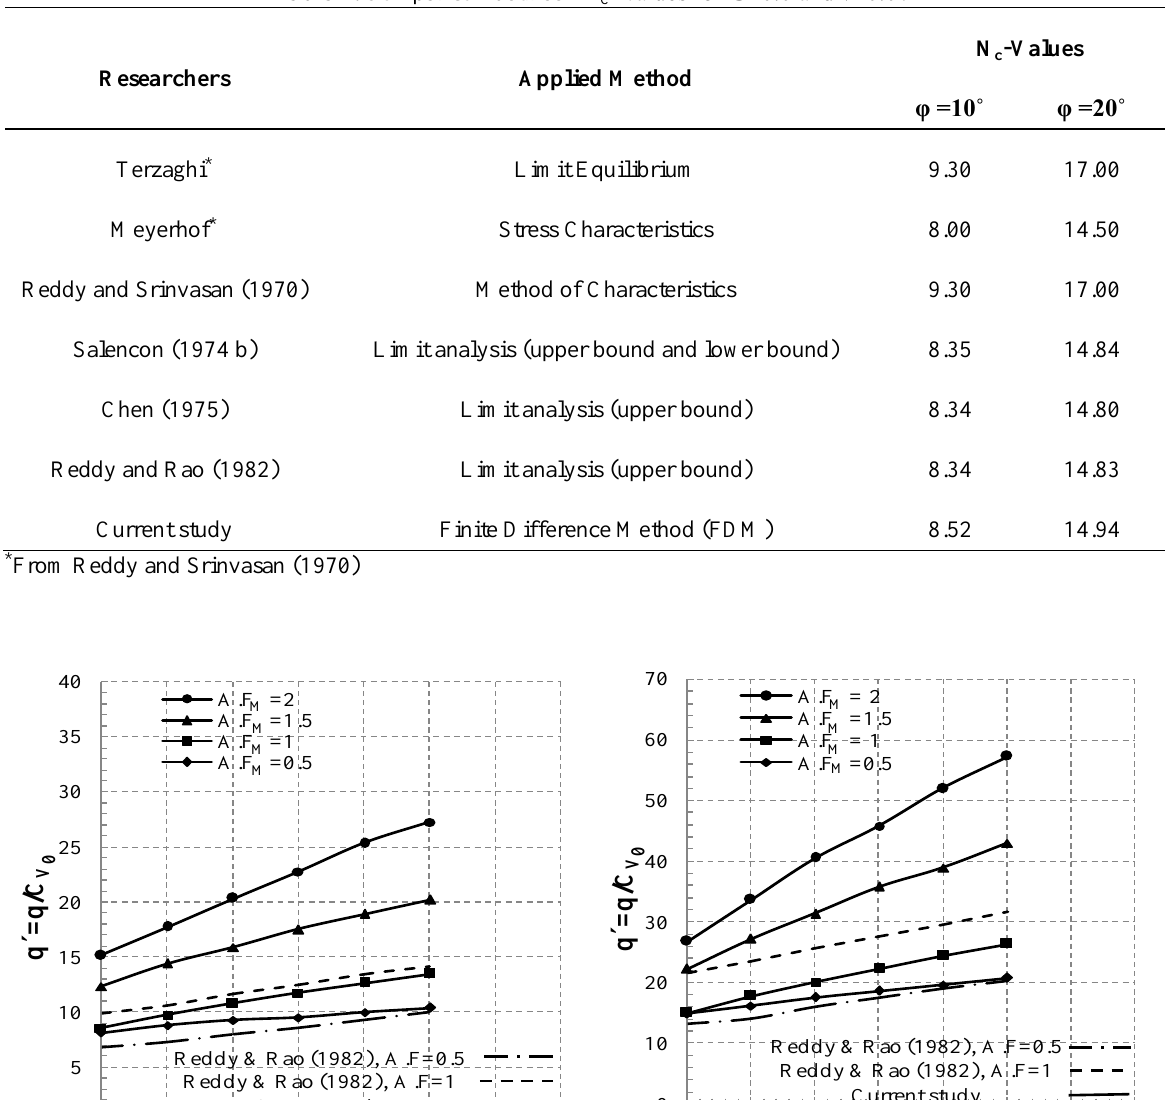
Table 4. Comparison between N